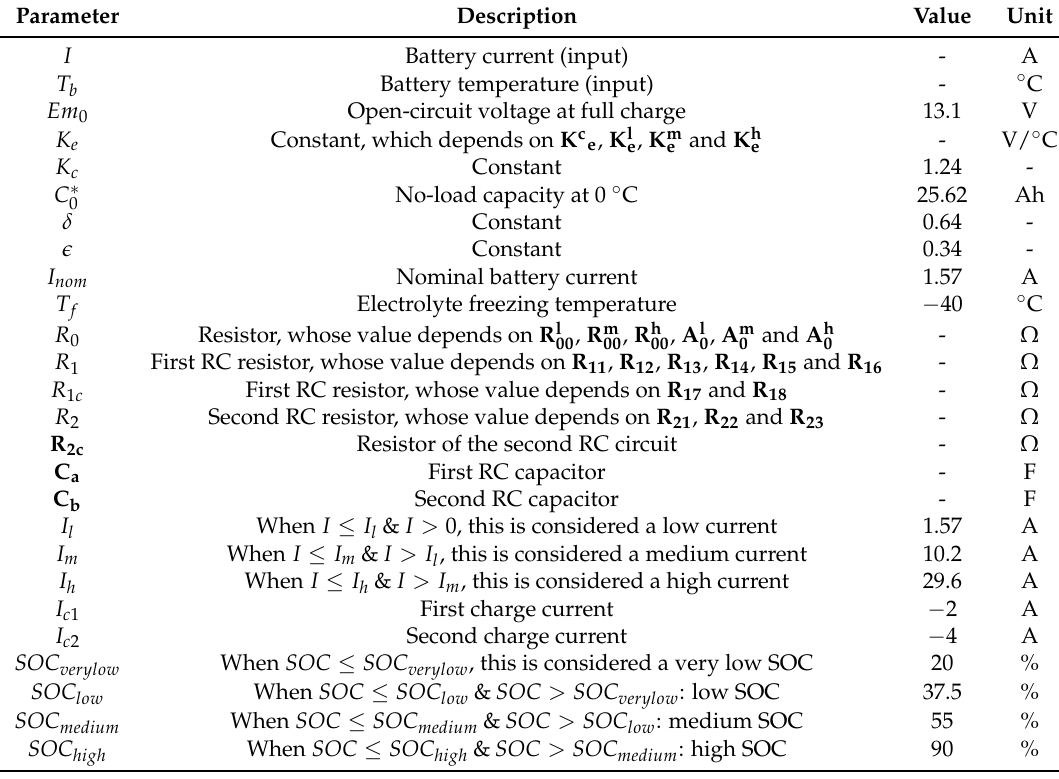
Figure 6. Battery model structures: ( a ) complete model ( C 1 ) ; ( b ) intermediate model ( C 2 ) ; and ( c ) simple model ( C 3 ) . Table 1. Table of symbols. The parameters in bold are the estimated